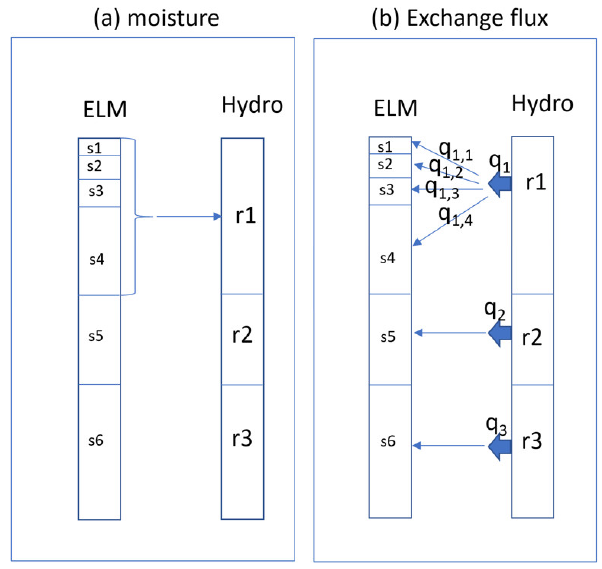
Figure 2. Mapping of soil water mass (a) and flux exchange (b) between the soil column in ELM and the rhizosphere in FATES- HYDRO. “s” stands for ELM soil layer, “r” stands for rhizosphere layer, and “q” is flux